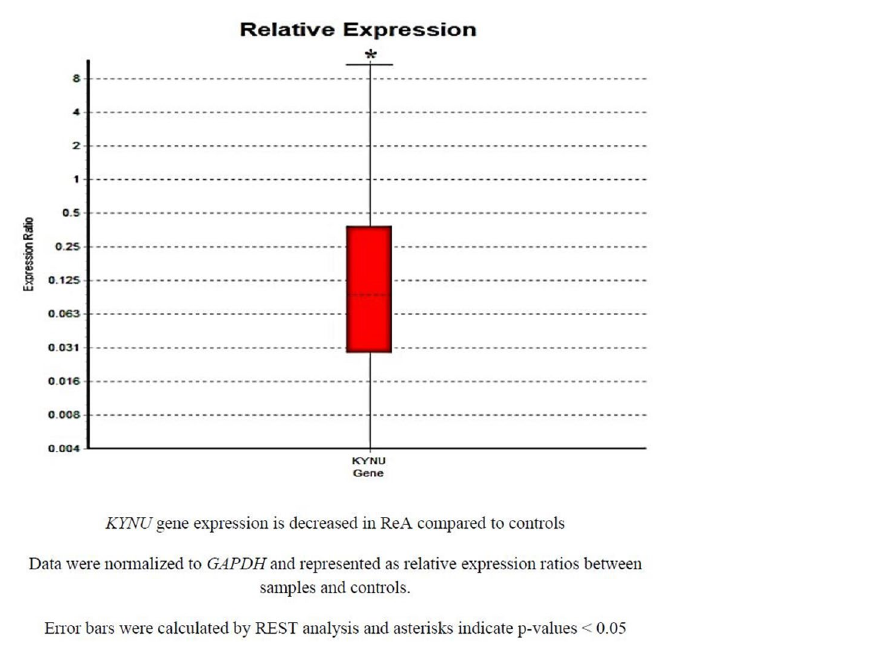
Figure 8. Relative expression of KYNU in cases vs